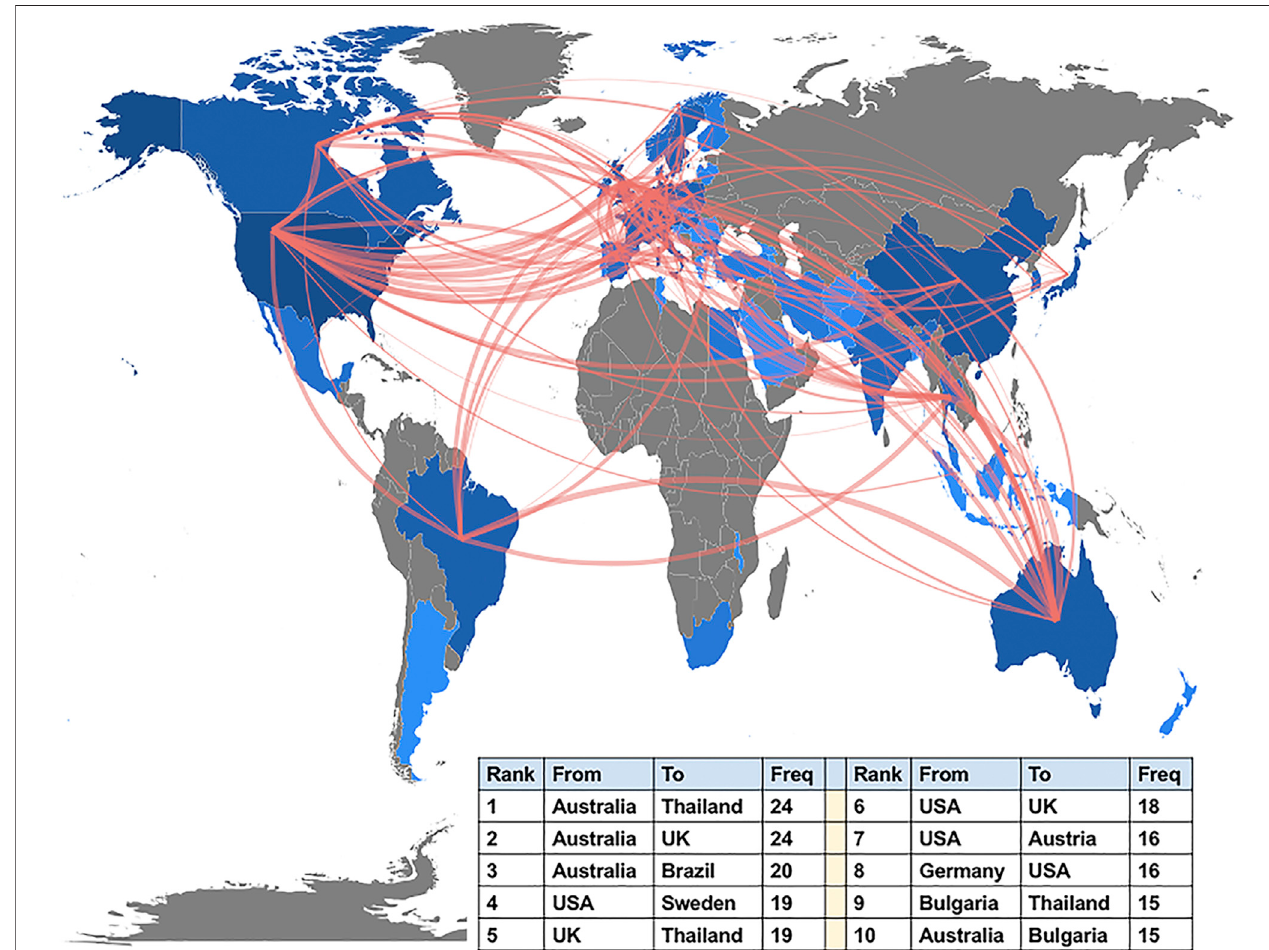
FIGURE 5 | Country/region collaboration map of studies associated with the kynurenine pathway (KP) in mood disorders, generated through the biblioshiny app. Note. USA, United States; UK, United Kingdom.